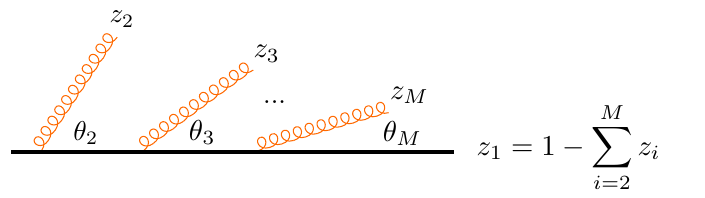
Figure 1. At strongly-ordered (SO) accuracy, all emissions (orange) in a jet are assumed to be collinear and soft, as well as strongly ordered. The parton initiating the jet (black) has momentum fraction z = 1 − P M z i ≈ 1 after the 1 i =2